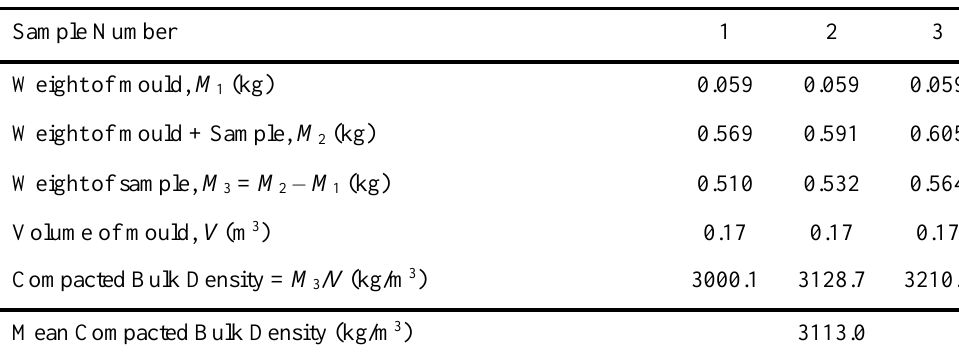
Table 7. Compacted Bulk Density (developed by the authors, based on